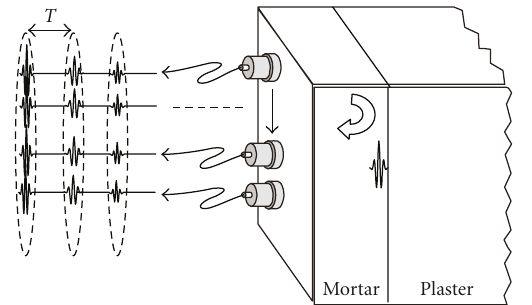
Figure 1: Schematic representation of the first layer interface.